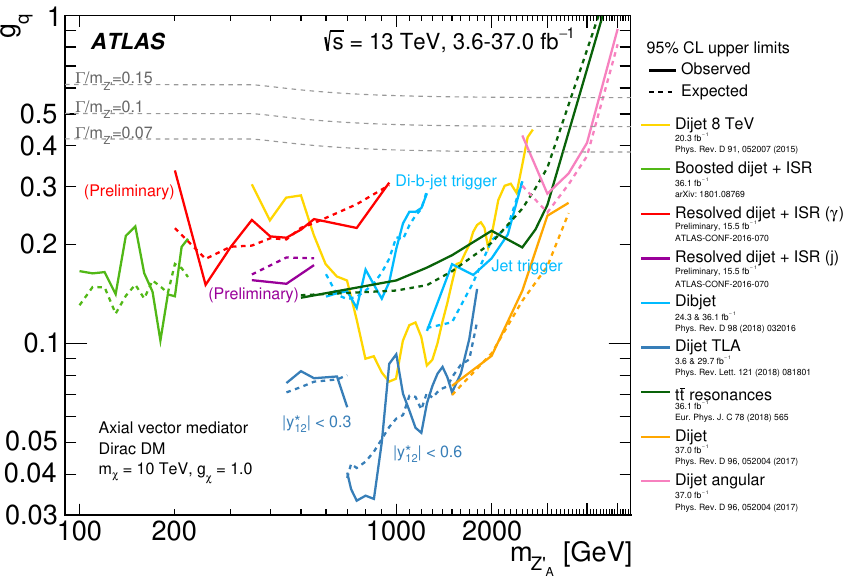
Figure 10. Dijet search contours for 95% CL upper limits on the coupling g q as a function of the resonance mass m for the leptophobic axial-vector Z 0 model. The expected limits from Z 0 A A each search are indicated by dotted lines. For illustrative purpose, the dijet + ISR Preliminary searches are shown in the plot. The TLA dijet analysis has two parts, employing di(cid:11)erent datasets with di(cid:11)erent selections in the rapidity di(cid:11)erence y (cid:3) as indicated. The yellow contour shows